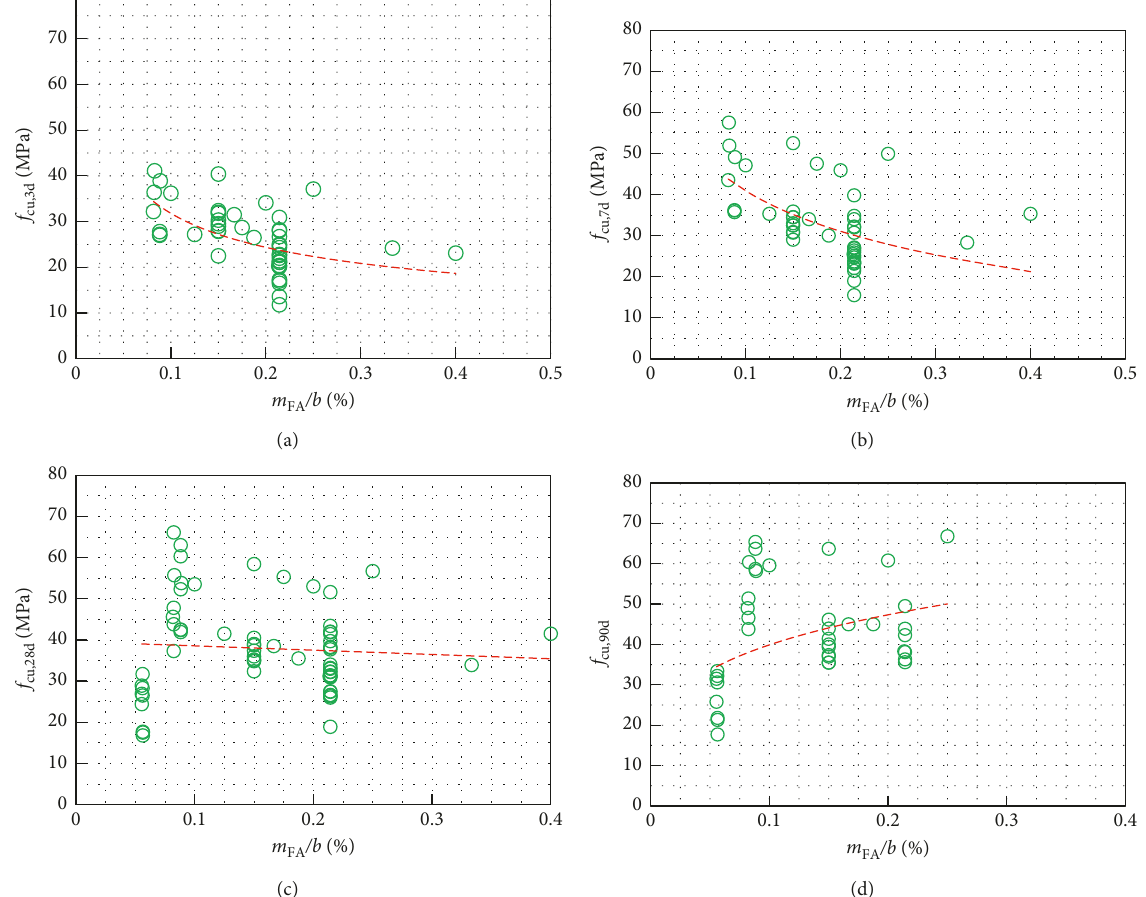
Figure 8: Effect of (m) FA /(b) on (f) cu,N . (a) At 3 days. (b) At 7 days. (c) At 28 days. (d) At 90 days.